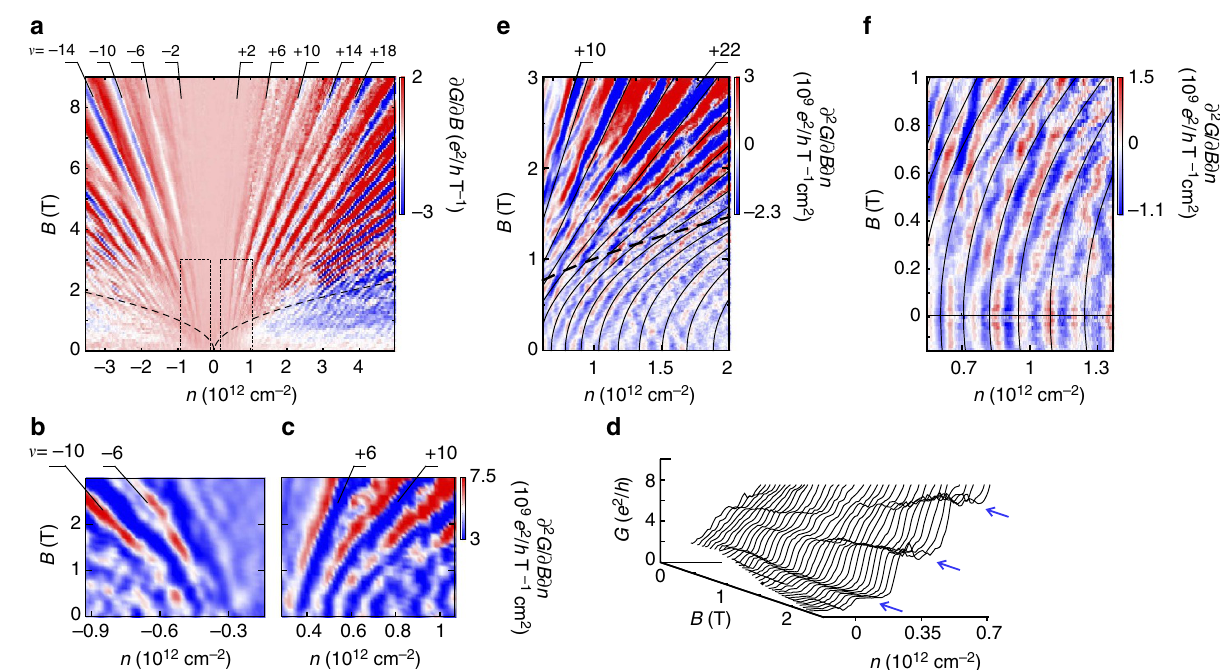
Figure 5 | Magnetic-field dependence of the size quantization. ( a ) Landau level fan of the graphene quantum point contact of width W E 230nm, measured at T ¼ 1.7K. Landau levels emerge at high magnetic fields. The magnetic-field quantization of Landau level m dominates over size quantization p as soon as 2 ffiffiffiffiffiffiffi 2 m l B (where the magnetic length l B (cid:6) 25 = ffiffiffiffiffiffiffiffi B ½ T (cid:5) p nm) is smaller than the constriction width ( B -field values above dashed black line). ( b , c ) Double-derivative plots of the regions delimited by thin dashed lines in a showing the evolution of the lowest quantization plateaus with magnetic field: we observe the full transition from quantized sub-bands ( B ¼ 0T) to Landau levels at large B -field. ( d ) The same magnetic-field evolution is visible in the conductance as a function of magnetic field and charge carrier density for a different cool-down of the same device, also measured at 1.7K. The blue arrows highlight the expected quantum Hall conductance plateaus at 2, 6 and 10 e 2 / h . ( e ) Double-derivative plot of the conductance as a function of magnetic field and charge carrier density measured at T ¼ 6K. The solid black lines denote the theoretical expectations for the evolution of the size quantization with magnetic field. The thick dashed black line corresponds to the boundary of the Landau level regime, also appearing in a . ( f ) Zoom-in of e for small magnetic fields B r